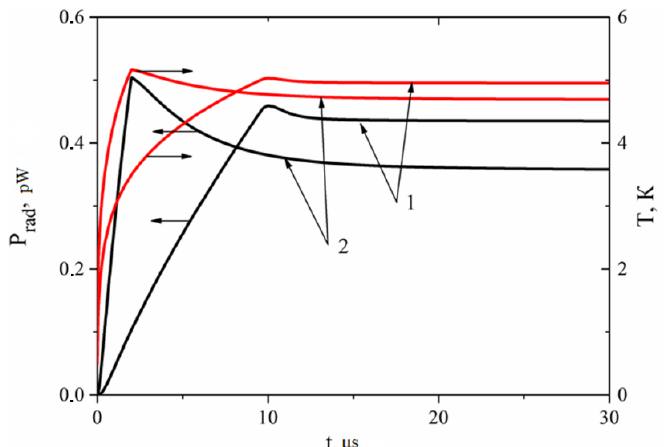
Figure 12. Calculation of changing temperature (T, red curves) and radiation power (P rad , black curves) at applied pulse of 10 μ s (1) and 2 μ s (2) and 20 and 40 V starting at t = 0. Pulse power applied to nichrome film is 0.19 and 0.75 W/cm 2 . Graph from [12] with permission, Copyright 2018 Pleiades Publishing, Ltd.